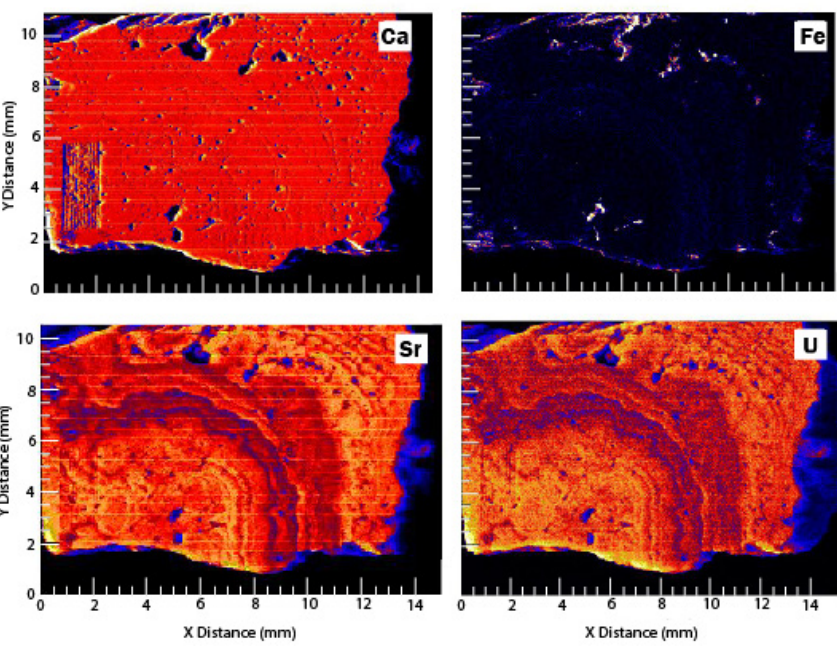
Figure 10. On the fly synchrotron XRF maps of Ca, Fe, Sr, and U for a slab of Barstow tufa. This is from the same suite of samples being characterized for a LAcarb reference material, and it serves to show the relationships between U, Fe, and Sr in the Barstow tufa samples.